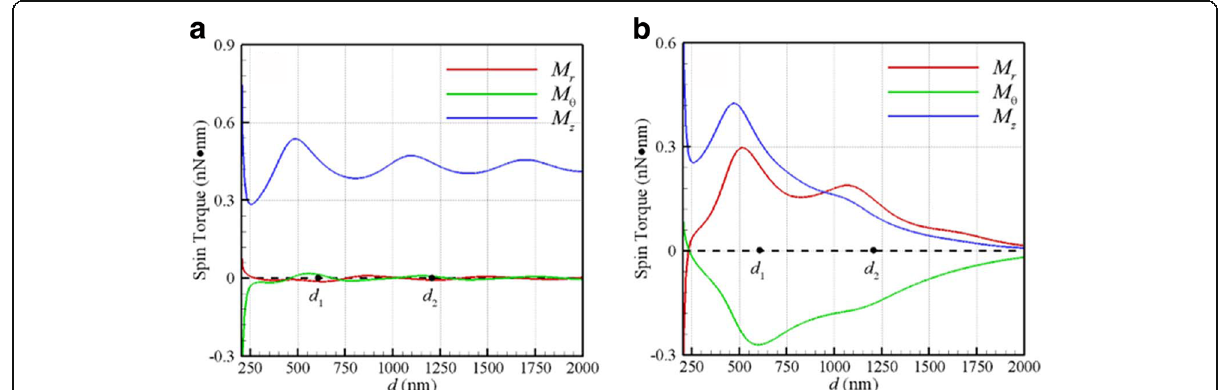
Fig. 3 Optical spin torques ( M r , M θ , M z ) versus d at λ = 800 nm for a plane wave and b Gaussian beam with w 0 = 500 nm at focal